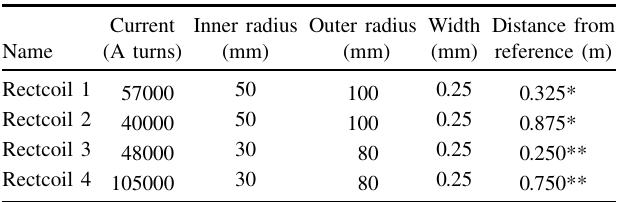
TABLE XIII. Solenoid parameters. Note that after the 90 (cid:3) spectrometer dipole, a change in the reference system takes place. The single-starred distances are measured from the ion source, the double-starred distances are measured from the spectrometer dipole.